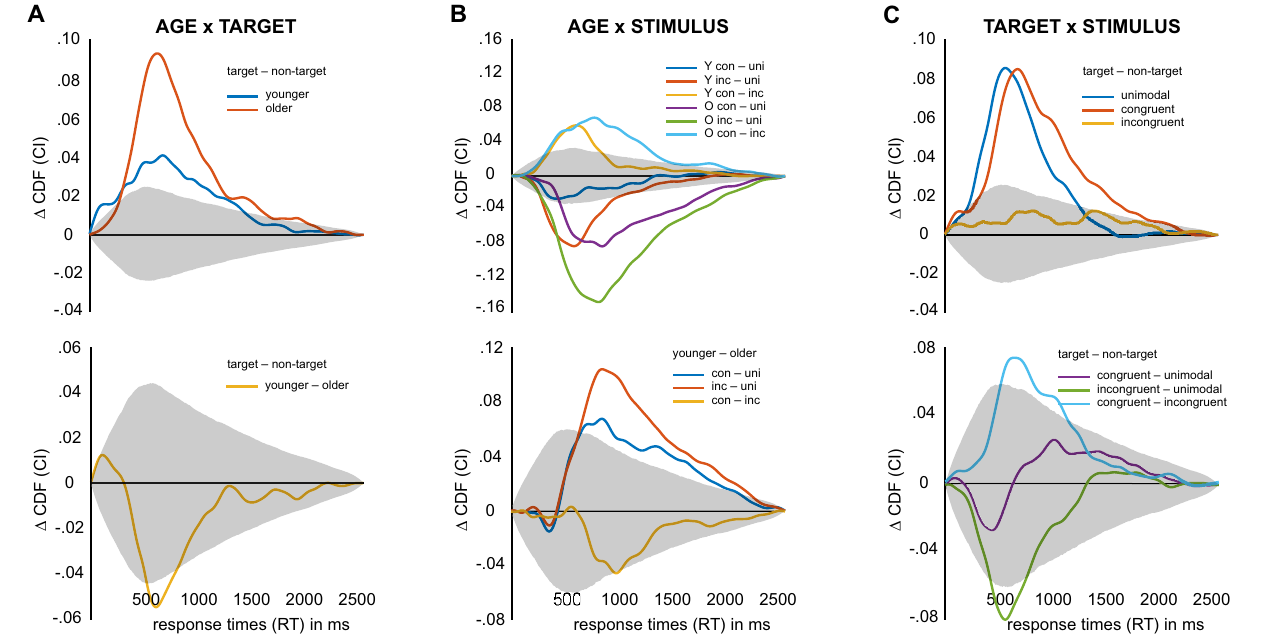
Figure 4. Interactions between experimental factors AGE, TARGET and STIMULUS on cumulative distribution functions (CDFs) of response times (RTs). Grey shaded areas depict confidence intervals corrected for multiple testing. ( A ) Interaction between AGE and TARGET. (top) Simple effects of TARGET separately for both AGE groups. (bottom) Differences between simple effects of TARGET. ( B ) Interaction between AGE and STIMULUS. (top) Simple effects of STIMULUS separately for both AGE groups. (bottom) Differences between simple effects of STIMULUS. ( C ) Interaction between TARGET and STIMULUS. (top) Simple effects of STIMULUS for both levels of TARGET. (bottom) Differences between simple effects of